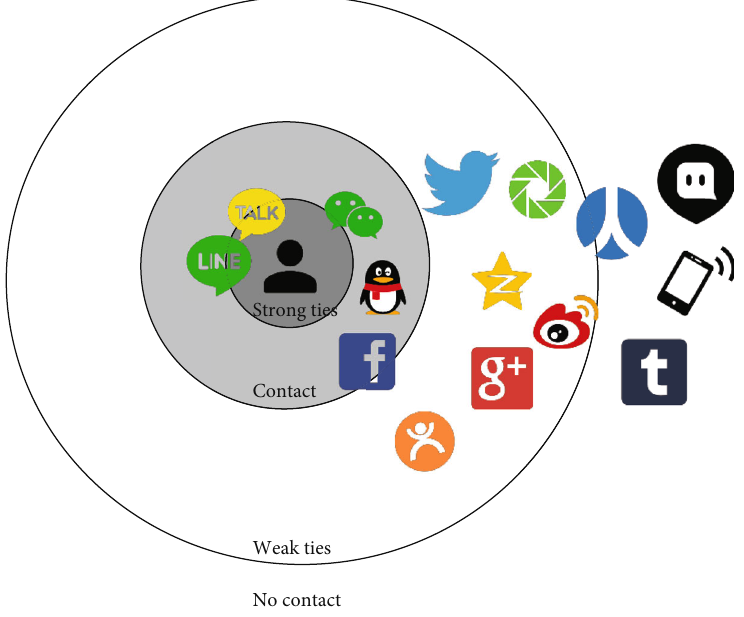
Figure 7: Social products at di ff erent social